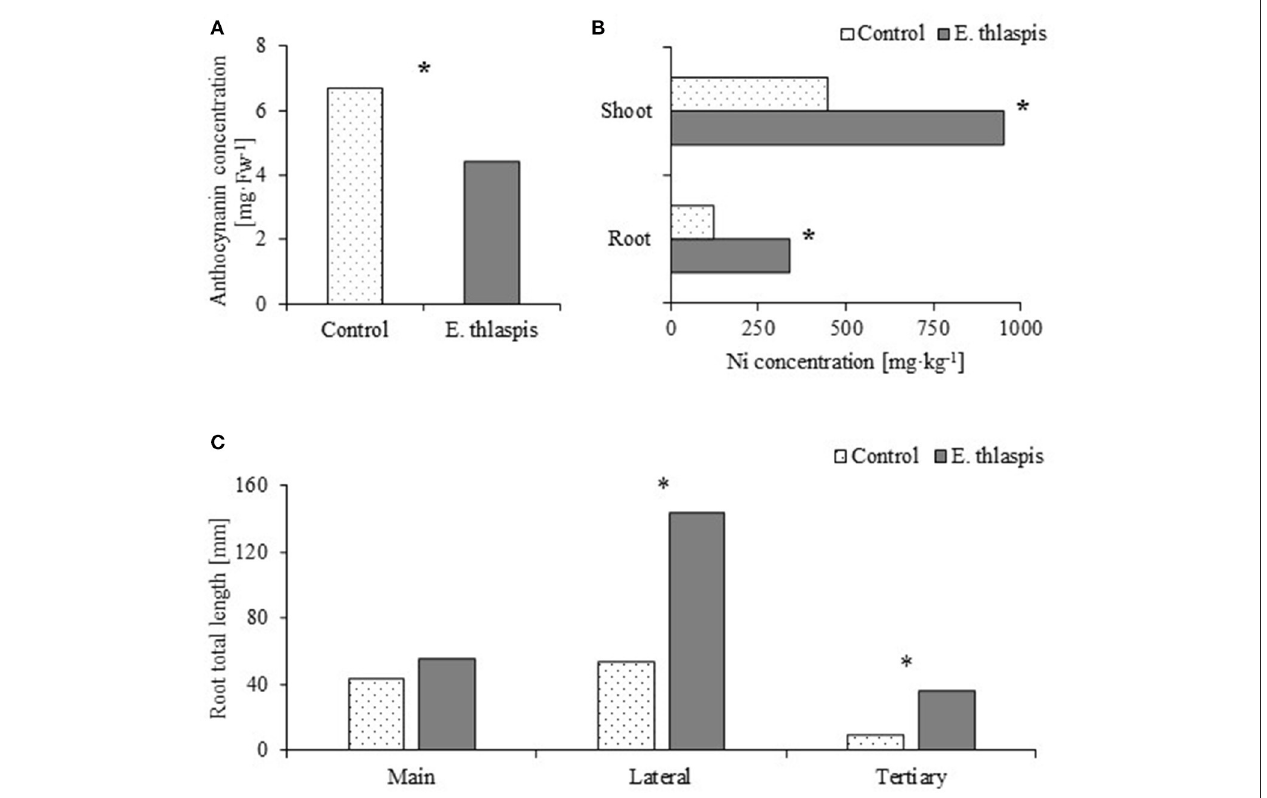
FIGURE 2 | The beneficial effect of endophytic fungus Embellisia thlaspis on Noccaea caerulescens . (A) Anthocyanin concentration [analyzed according to Fukumoto and Mazza (2000)]. (B) Ni accumulation in plant root and shoot (analyzed by Atomic Absorption Spectrometry). (C) Changes in root architecture. Statistical significances were evaluated with the t -test, P ≤ 0.0.05, N = 5 (in A , C ) and N = 50 (in B ). Plants were grown in sand mixed with perlite (1:1; v:v) for 50 days in a vegetation chamber with a 16h photoperiod and 21/17 ◦ C day/night temperature. Ten day-old seedlings were inoculated with 3ml of mycelium suspended in water (OD 600 = 0.15). Fourteen days after inoculation the substrate was supplemented with 150 µ M of NiSO 4 in Hoagland solution. Plants were irrigated with Hoagland solution twice per week. *Indicates statistical significance between inoculated and control. Data based on Rozp¸adek et al.